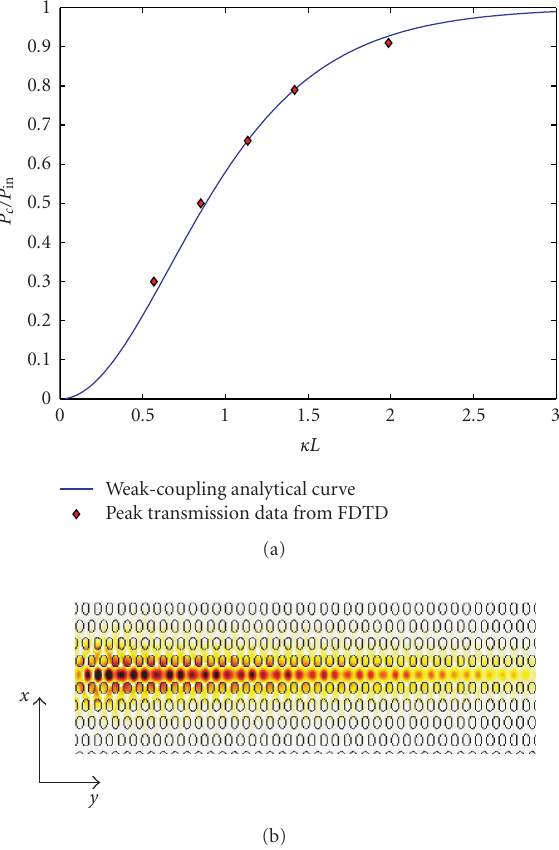
Figure 6: (a) Verification of weak-coupling (2). Only the coupling length L is varied in the PCSW 2 case. The peak transmission data from FDTD matches the analytical curve of (2). (b) E x field profile in PCSW 2 generated by counter-directional coupling for L = 40 a